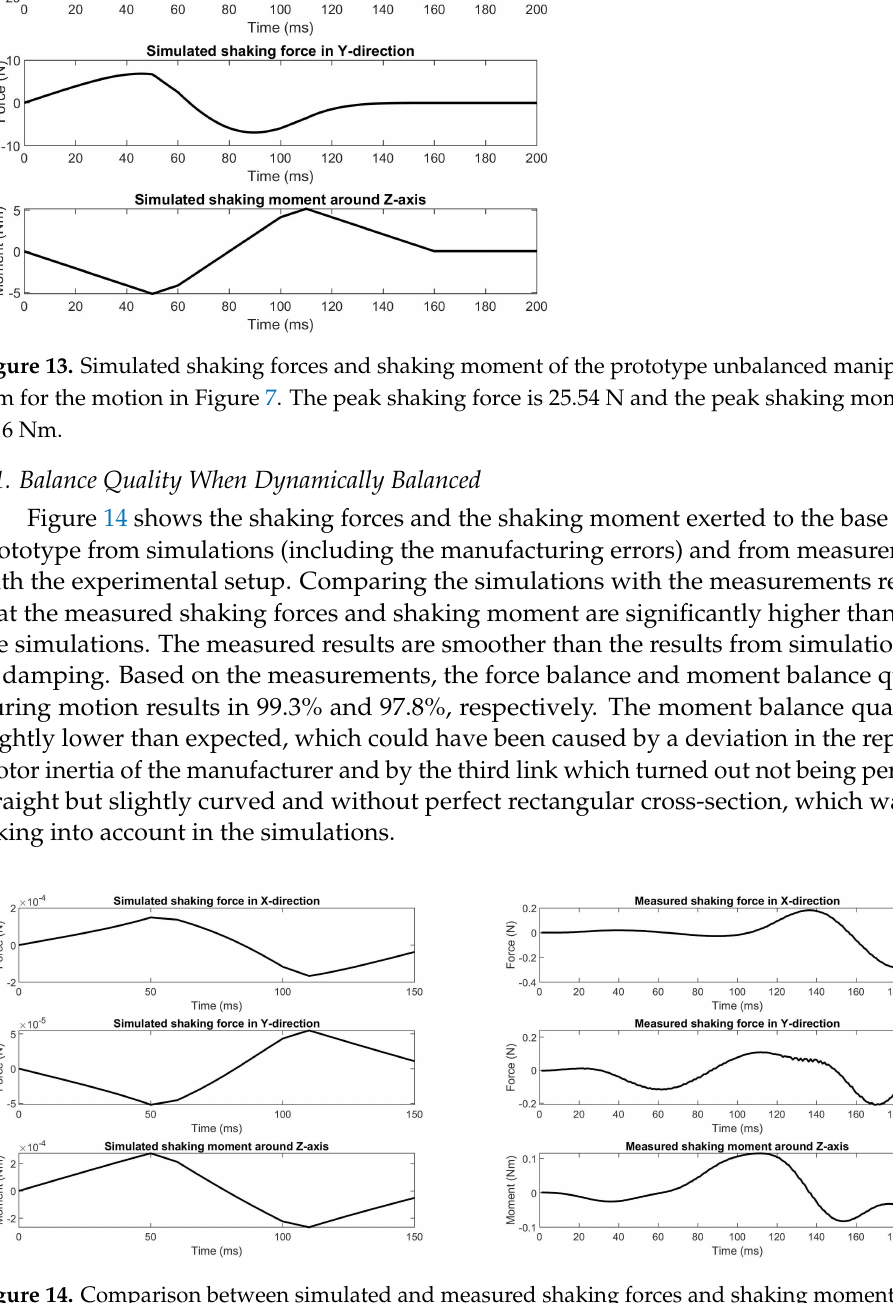
Figure 14. Comparison between simulated and measured shaking forces and shaking moment of the balanced mechanism, with a maximal tip acceleration of 5.2